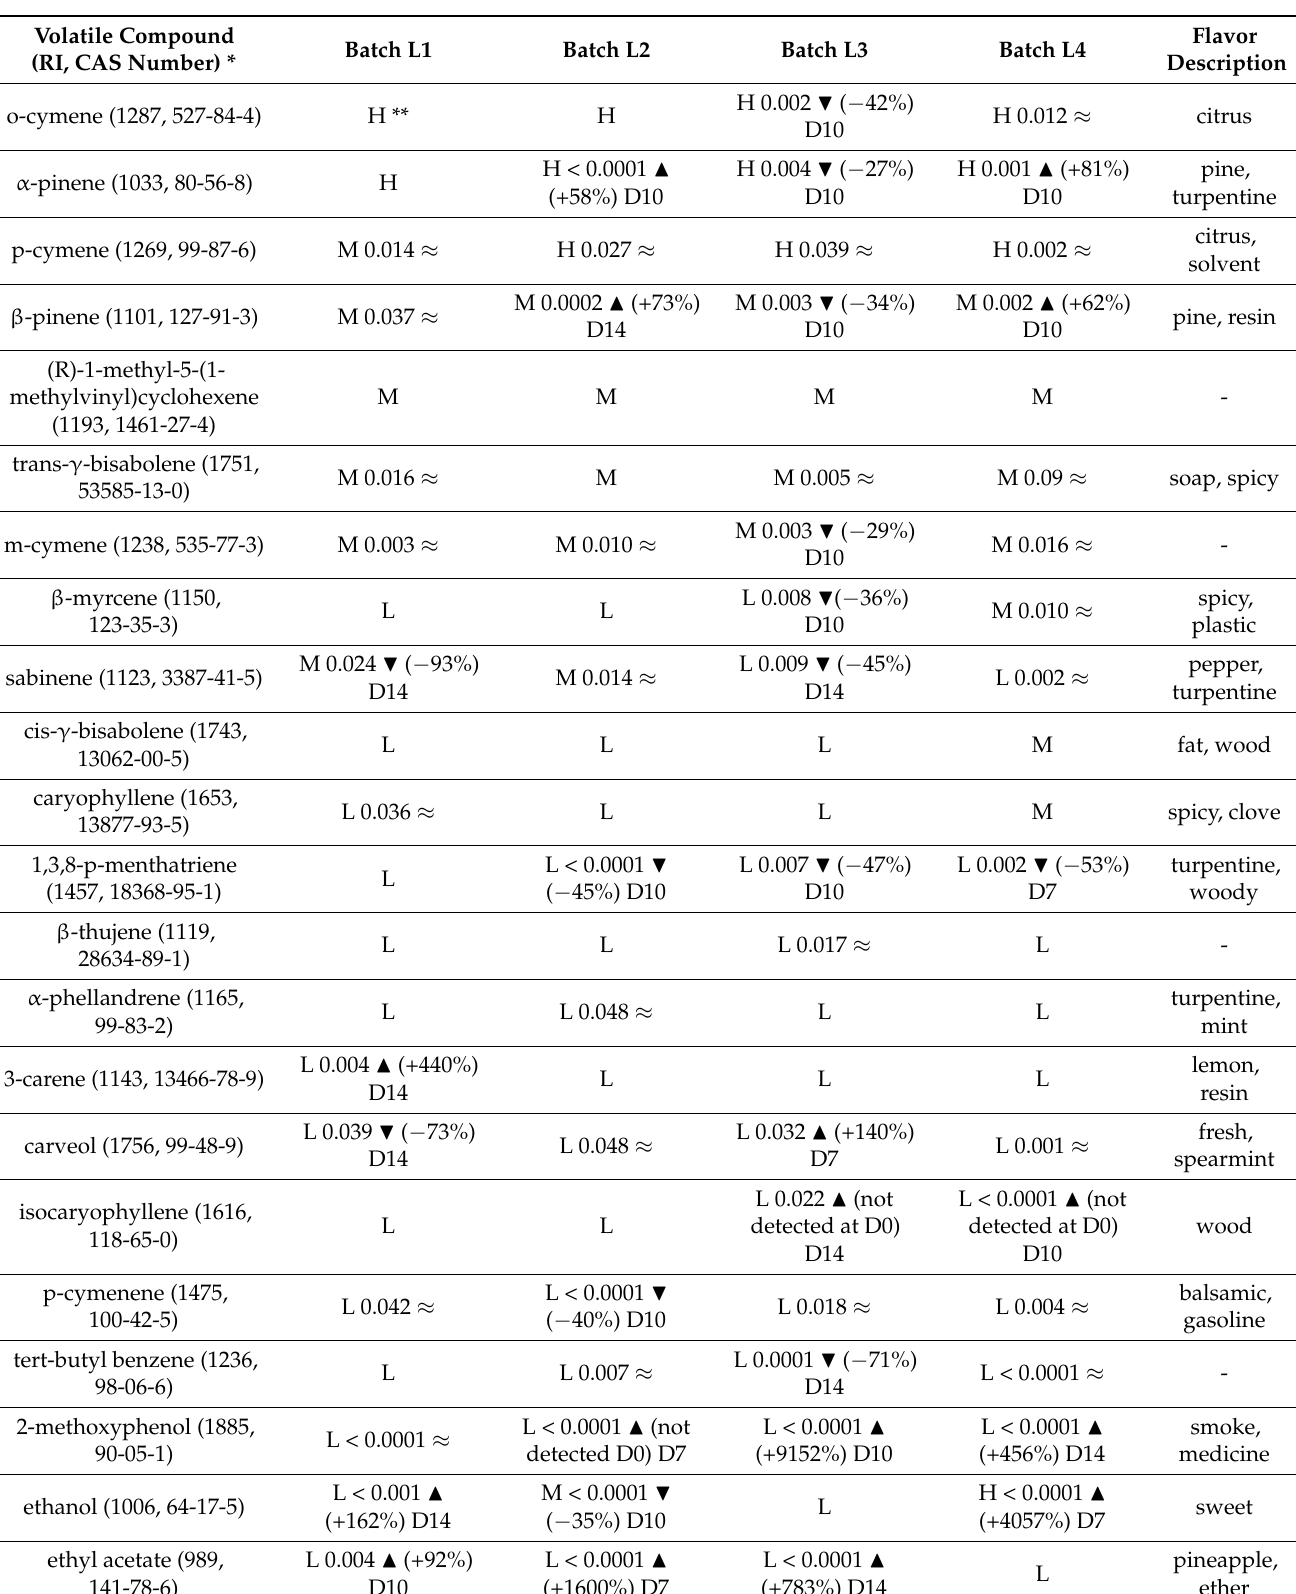
Table 2. Volatile compounds modifications during storage time for the four analyzed batches, L1, L2, L3 and L4, of carrot